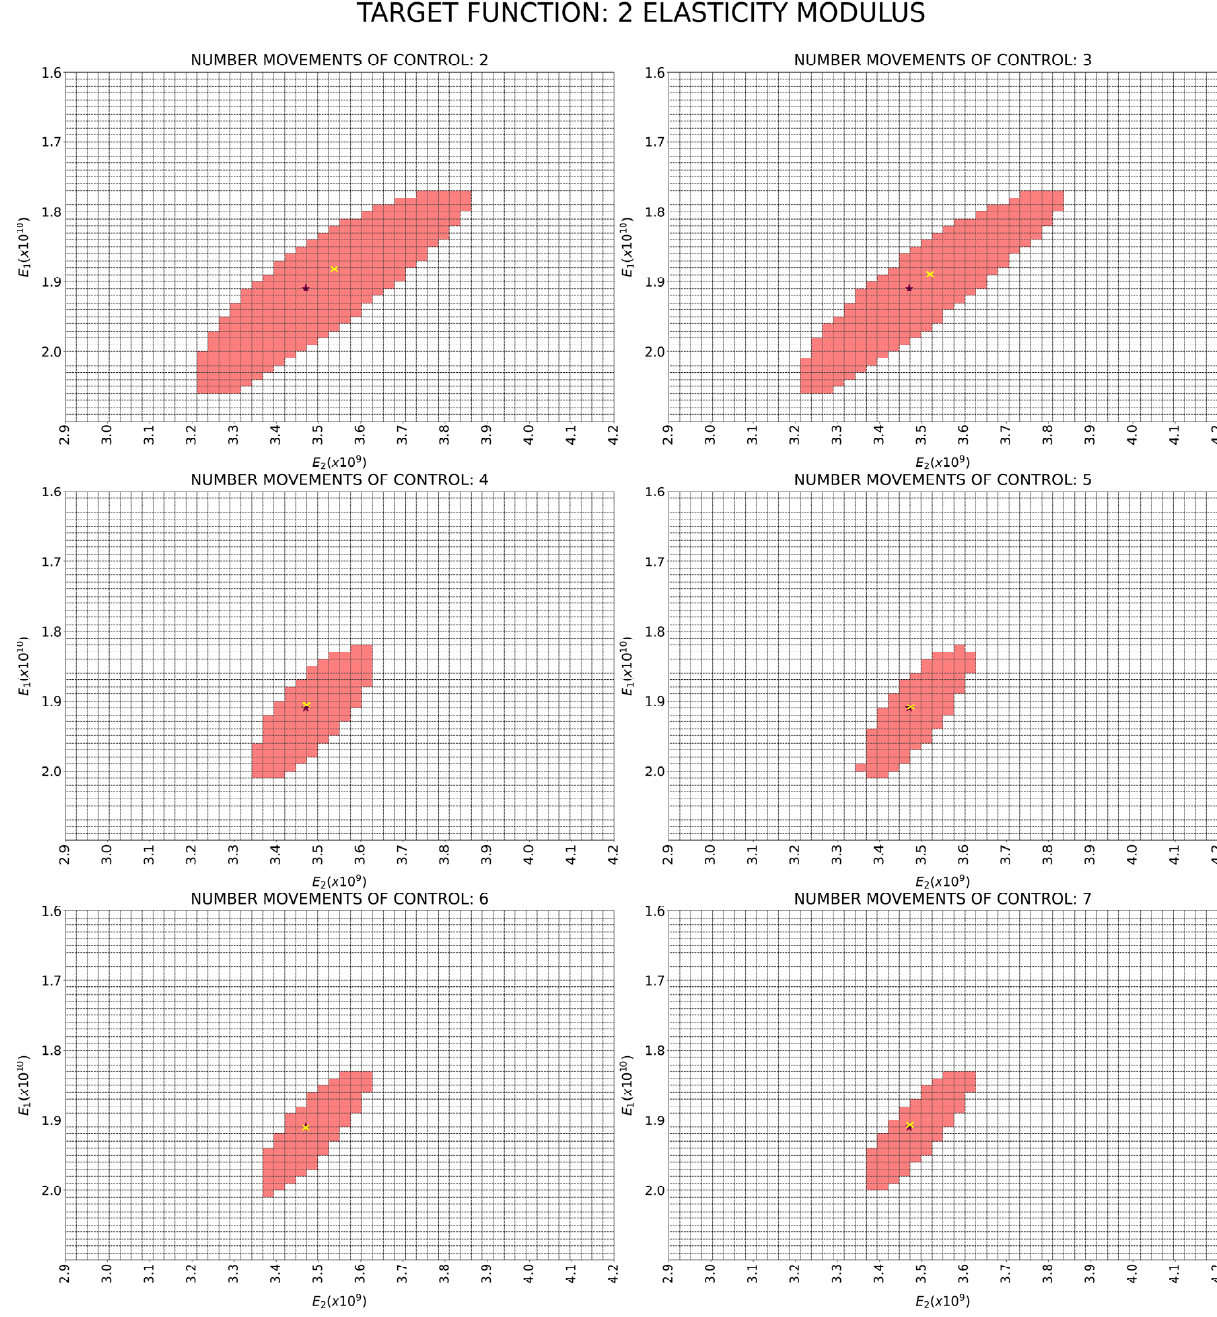
Figure 6. Calibration of the dam with homogeneous foundation with different numbers of control movements. (E 1 modulus of elasticity of concrete (Pa); E 2 modulus of elasticity of the foundation (Pa)).